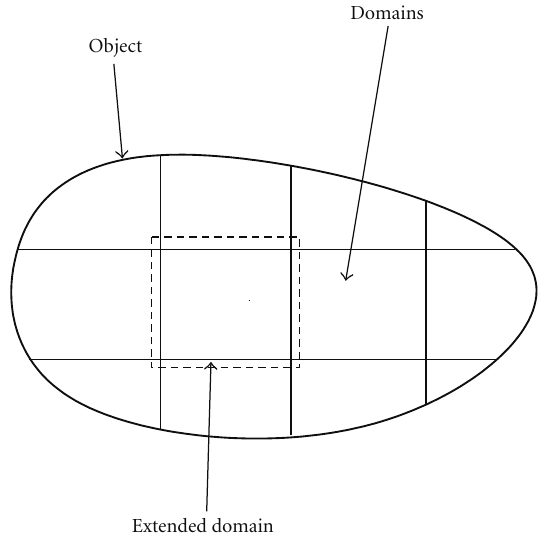
Figure 1: Scheme of the decomposition approach.